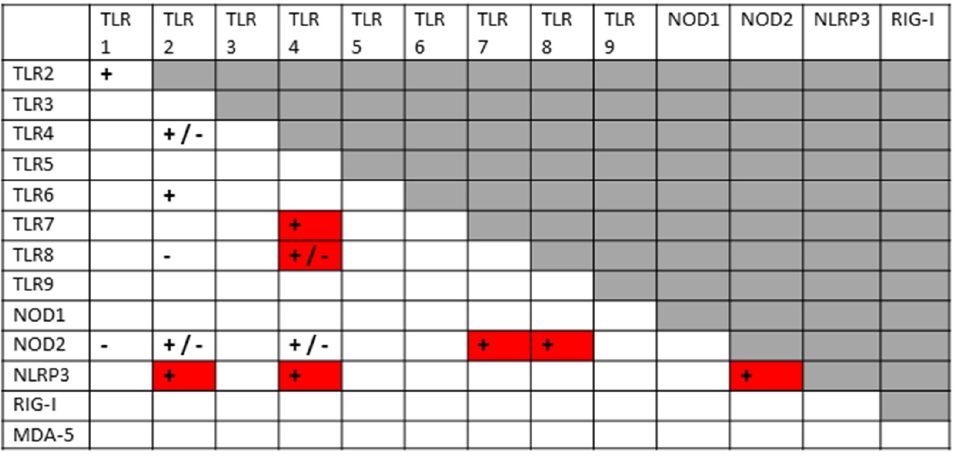
Figure 7. Predicted synergisms (+) and antagonisms ( − ) resulting from Kawasaki disease activation of innate receptors resulting from mapping Figure 3 (literature review of innate receptor activation) onto the template provided by Figure 2 (summary of known innate receptor synergisms and antagonisms). Red entries indicate extracellular (“bacterial antigen”) receptor synergisms with intracellular and endosomal (“viral antigen”) receptors.